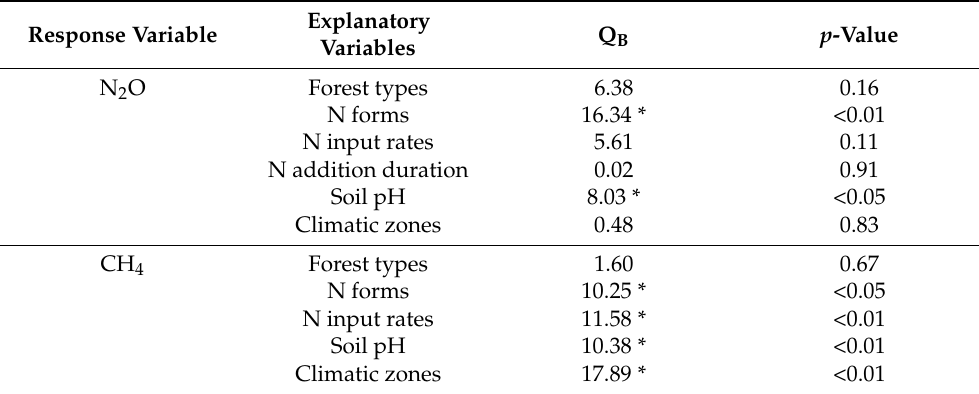
Table 1. Between-group heterogeneity (Q B ) showing potential as predictive variables influencing N 2 O and CH 4 fluxes in response to N input σ